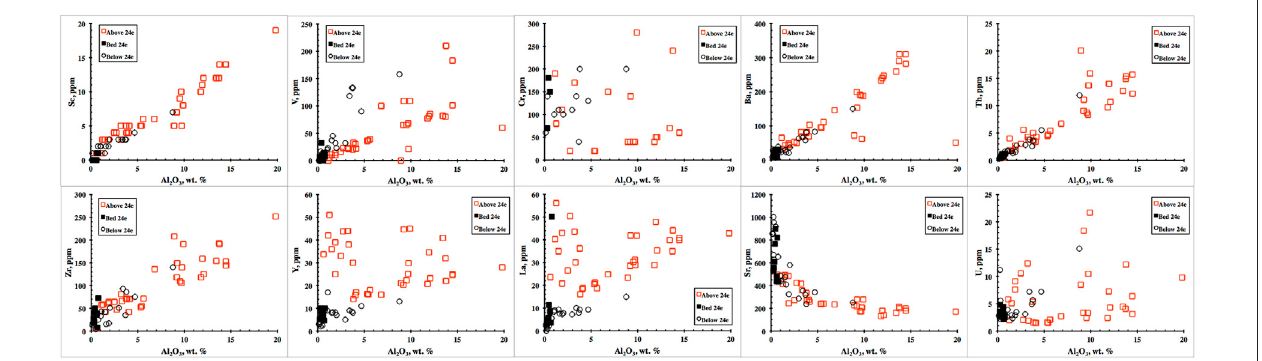
FIGURE 4 | Bivariate plots of selected trace element data. Data are plotted against Al 2 O 3 as an index of detrital input.